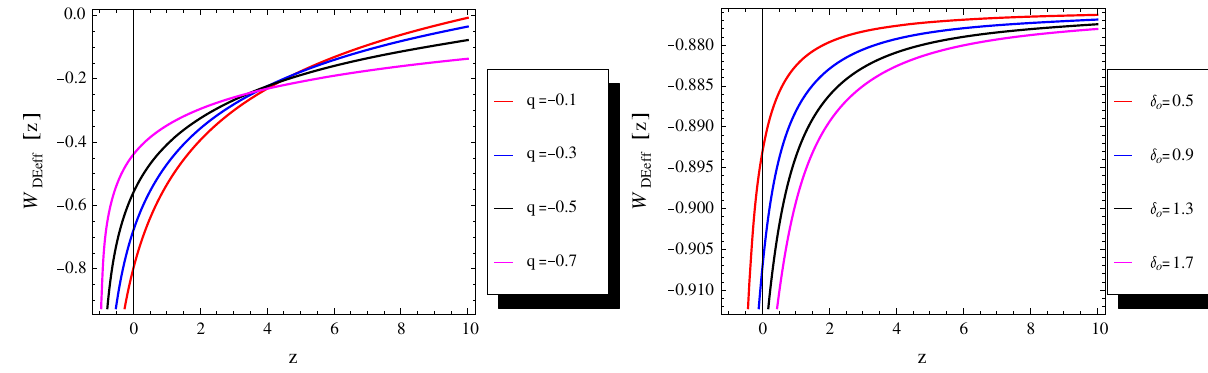
Fig. 3 The variations of EoS W DEef f for dark energy is depicted in the above graphs